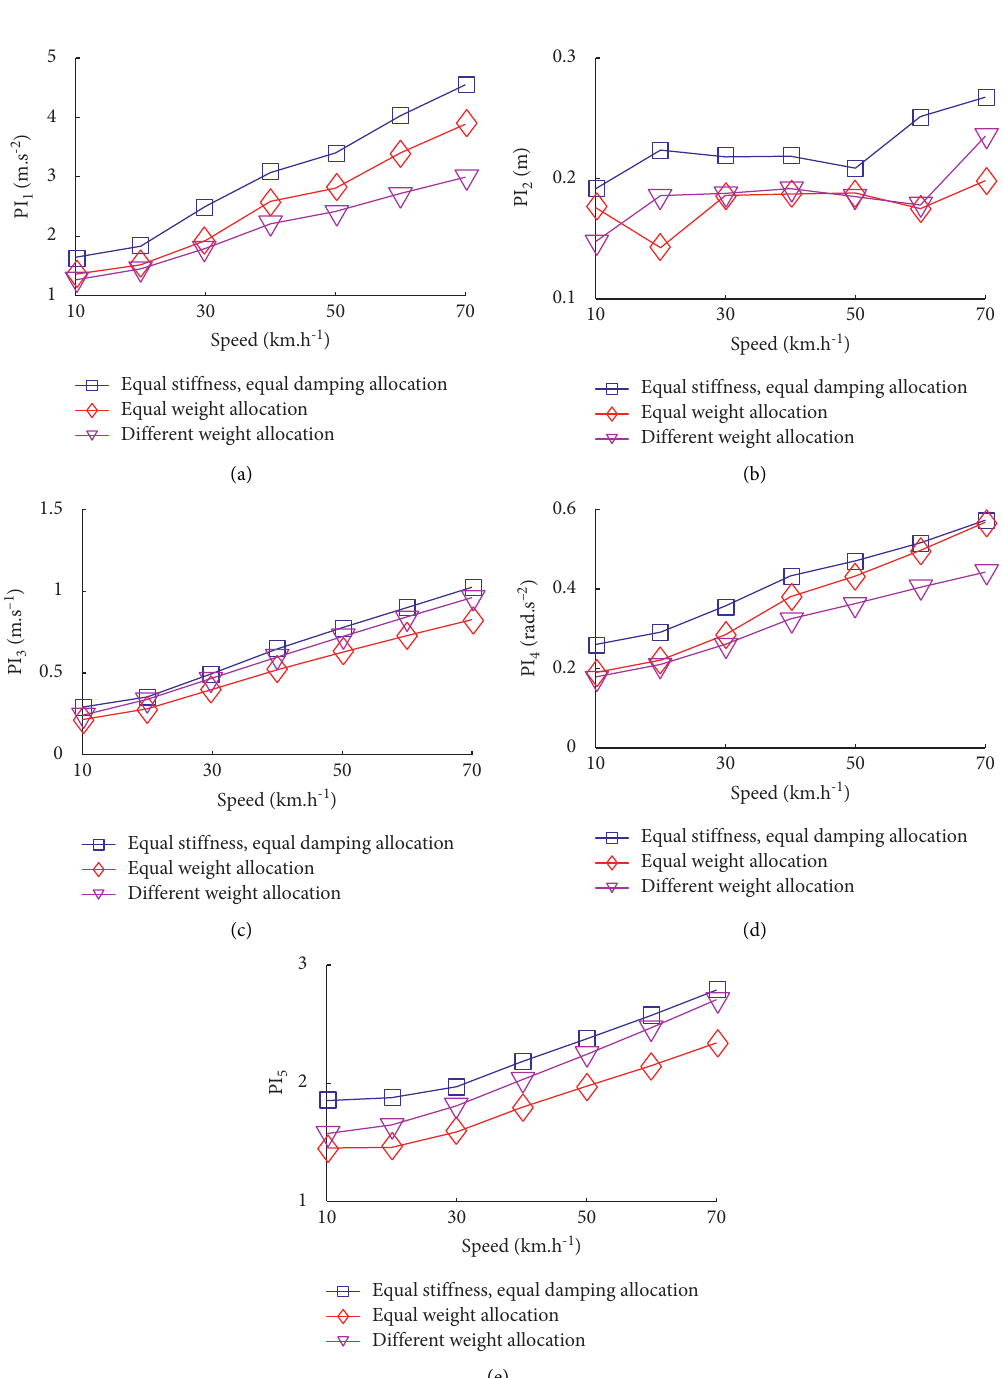
Figure 11: Comparison for the suspension system performance index (on rough